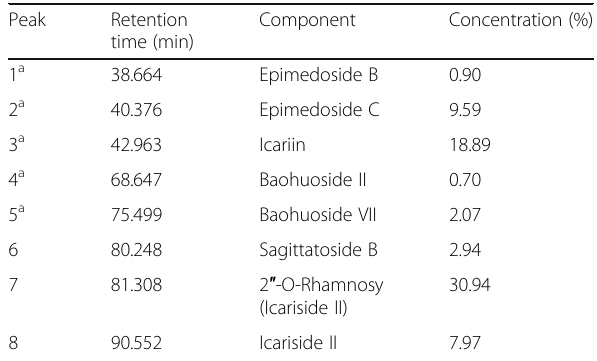
Table 2 The main components of YYHs